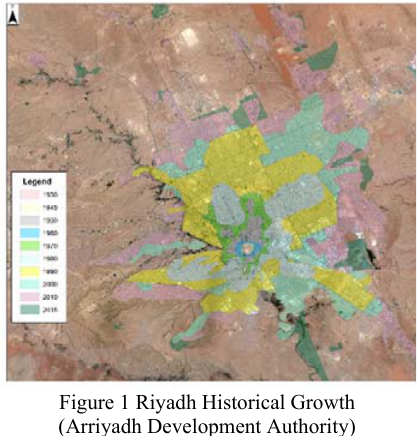
Figure 1 Riyadh Historical Growth (Arriyadh Development